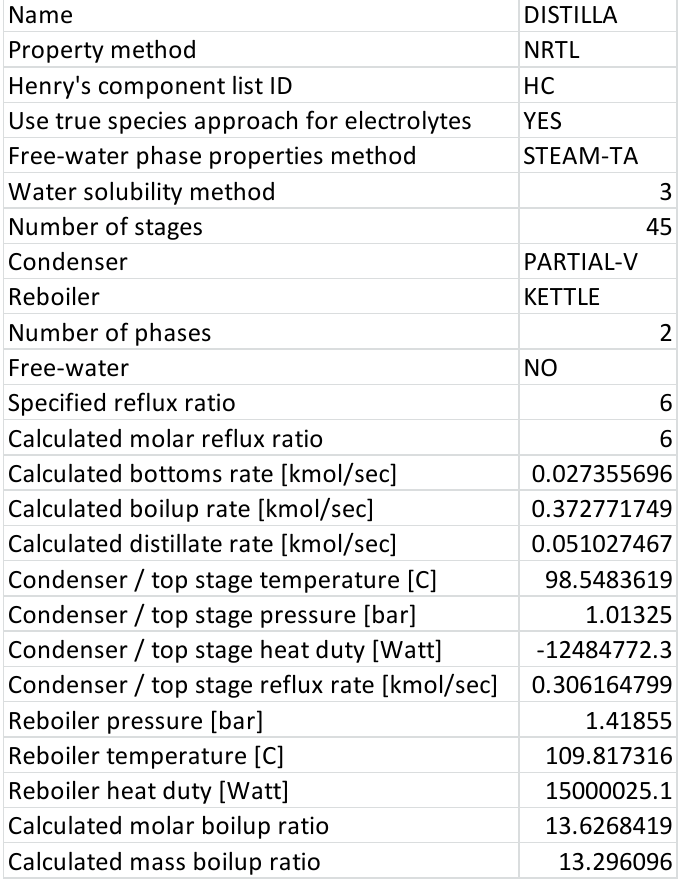
Figure A16. Fermentation distillation column results. Energies 2020 , 13 , x FOR PEER REVIEW